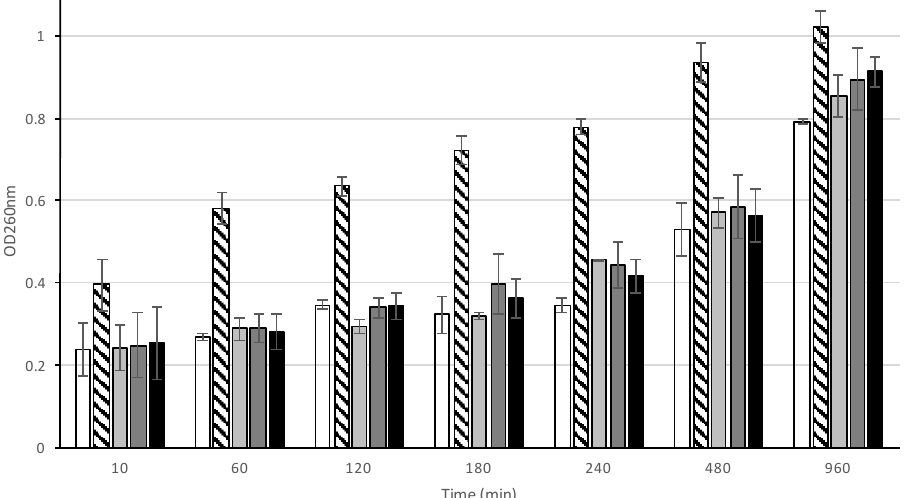
Figure 3. Cell leakage assay of MRSA CIP 106760 strain challenged with 7α-acetoxy-6β-hydroxyroyleanone. The optical density (OD 260nm ) of the cell supernatant was measured at discrete time points for MRSA CIP106760 in the presence of DMSO (white bar), CIP106760 challenged with 100 mg/L of lysostaphin (striped bar) and CIP106760 challenged with different concentrations of 7α-acetoxy-6β-hydroxyroyleanone; MIC/2 (3.9 mg/L; light grey bar); MIC (7.8 mg/L; dark grey bar) and 2 MIC (15.6 mg/L; black bar). Experiments were performed in triplicate. Shown are means with the standard error.